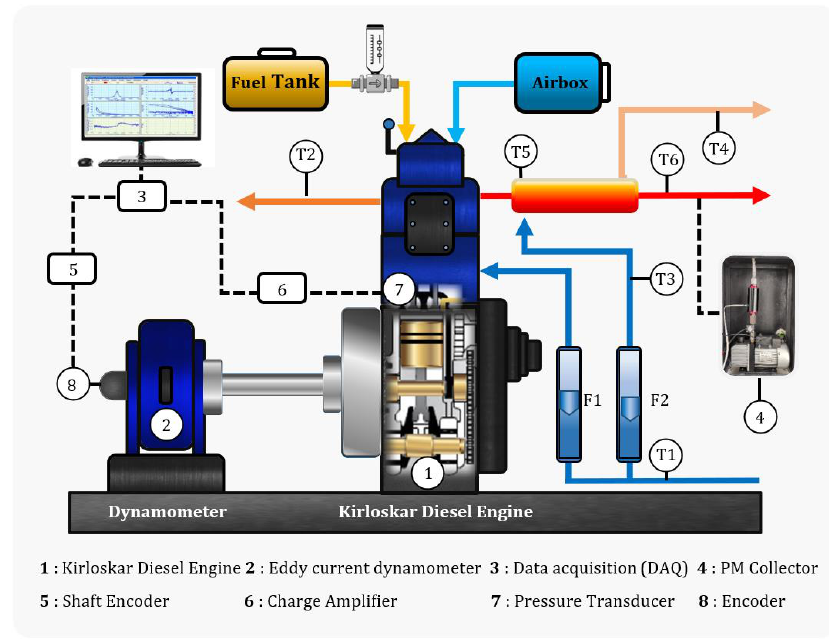
Figure 1. Layout of the diesel engine test rig. Table 2. Technical specification of measuring instruments.